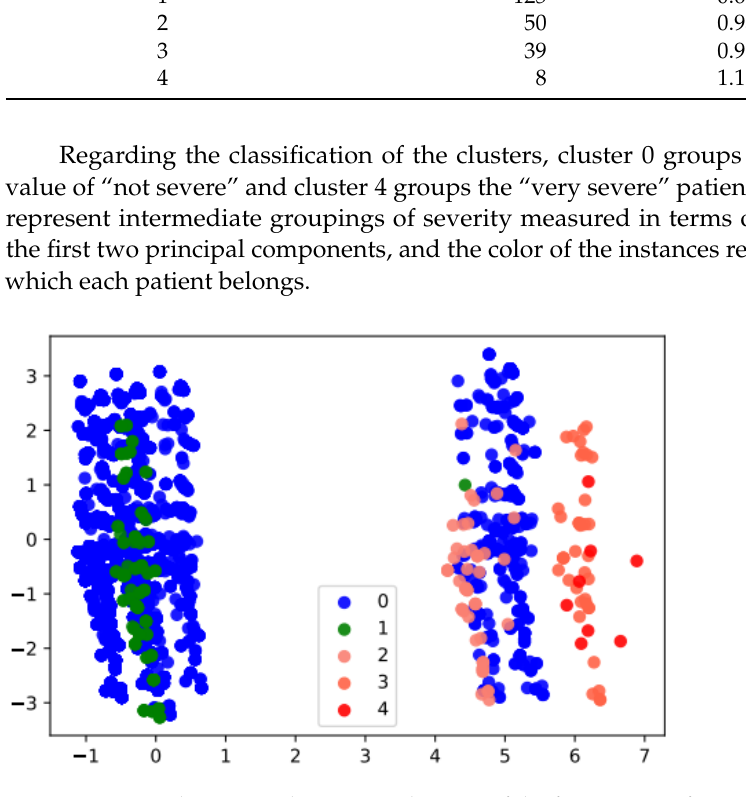
Figure 5. A two-dimensional PCA visualization of the five groups of patients identified by DBSCAN . Colors indicate the group of each